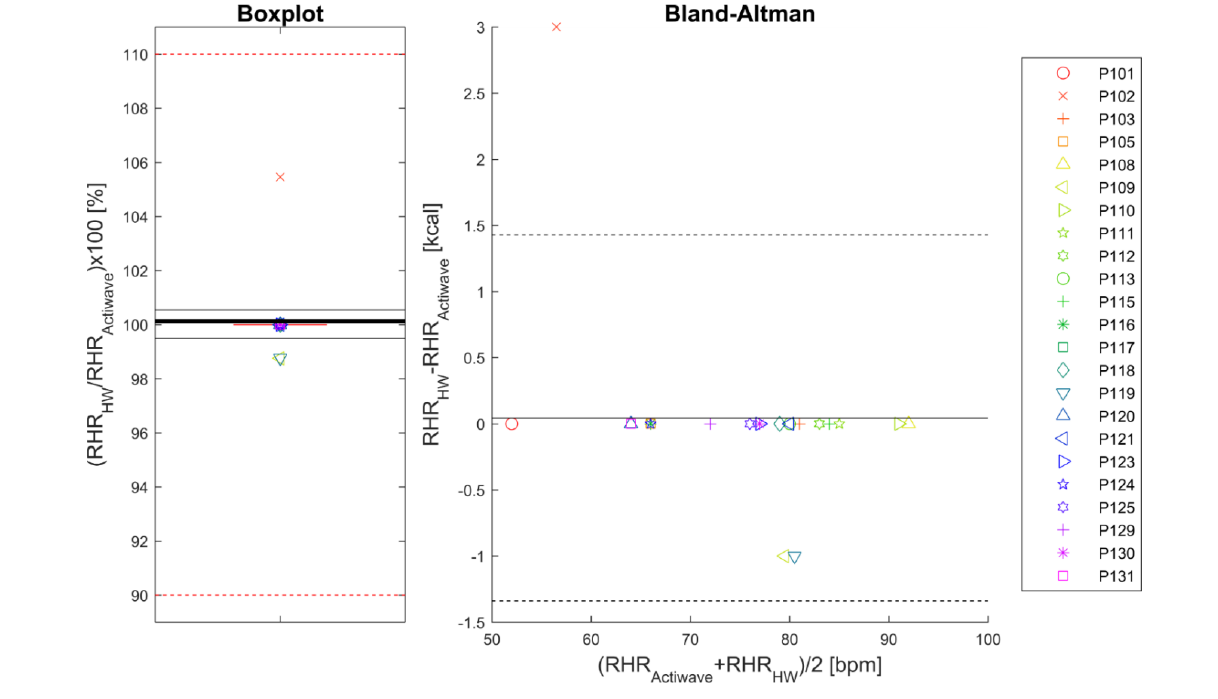
Figure 3. Boxplot (left-hand panel) of the ratio of resting heart rate (RHR) determined from the Philips health watch (HW) data during the rest protocol in the laboratory to the RHR determined from the Actiwave data during the rest protocol in the laboratory. The thick black line indicates the mean of the data, the red dashed lines the predefined equivalence interval, and the other black lines the calculated 95% CI of equivalence. Right-hand panel: Bland-Altman plot of the RHR from the HW and reference. The solid black line indicates the average bias and the dashed black lines represent the 95% limits of agreement. Symbols represent participants as indicated in the legend and are the same for both panels. bpm: beats per minute.